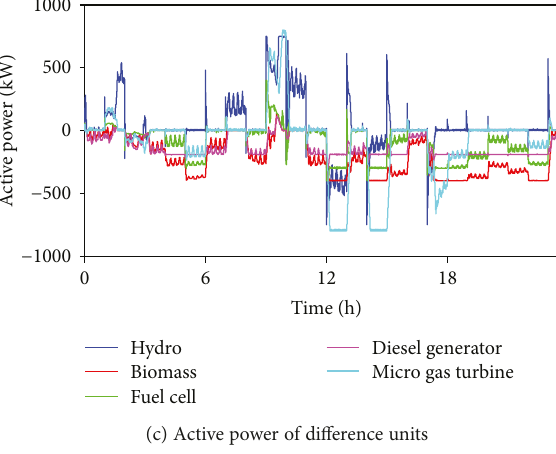
Figure 12: Power curve of EPCC.